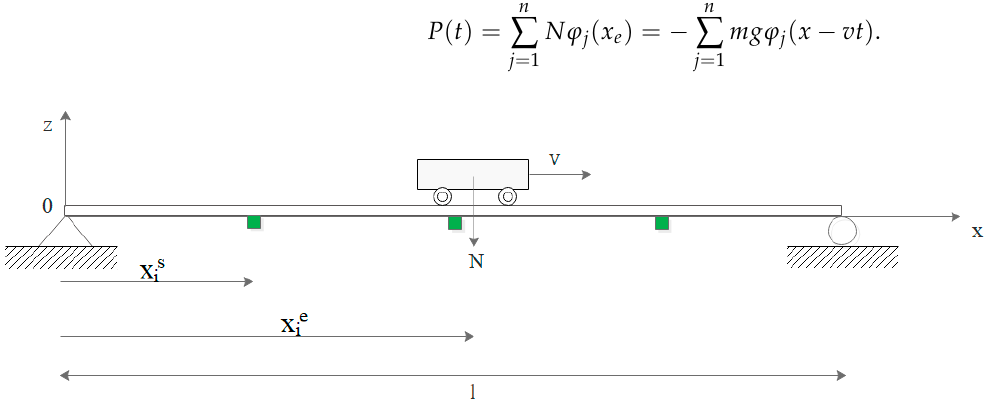
Figure 32. Model of the moving load passing a simply supported beam.